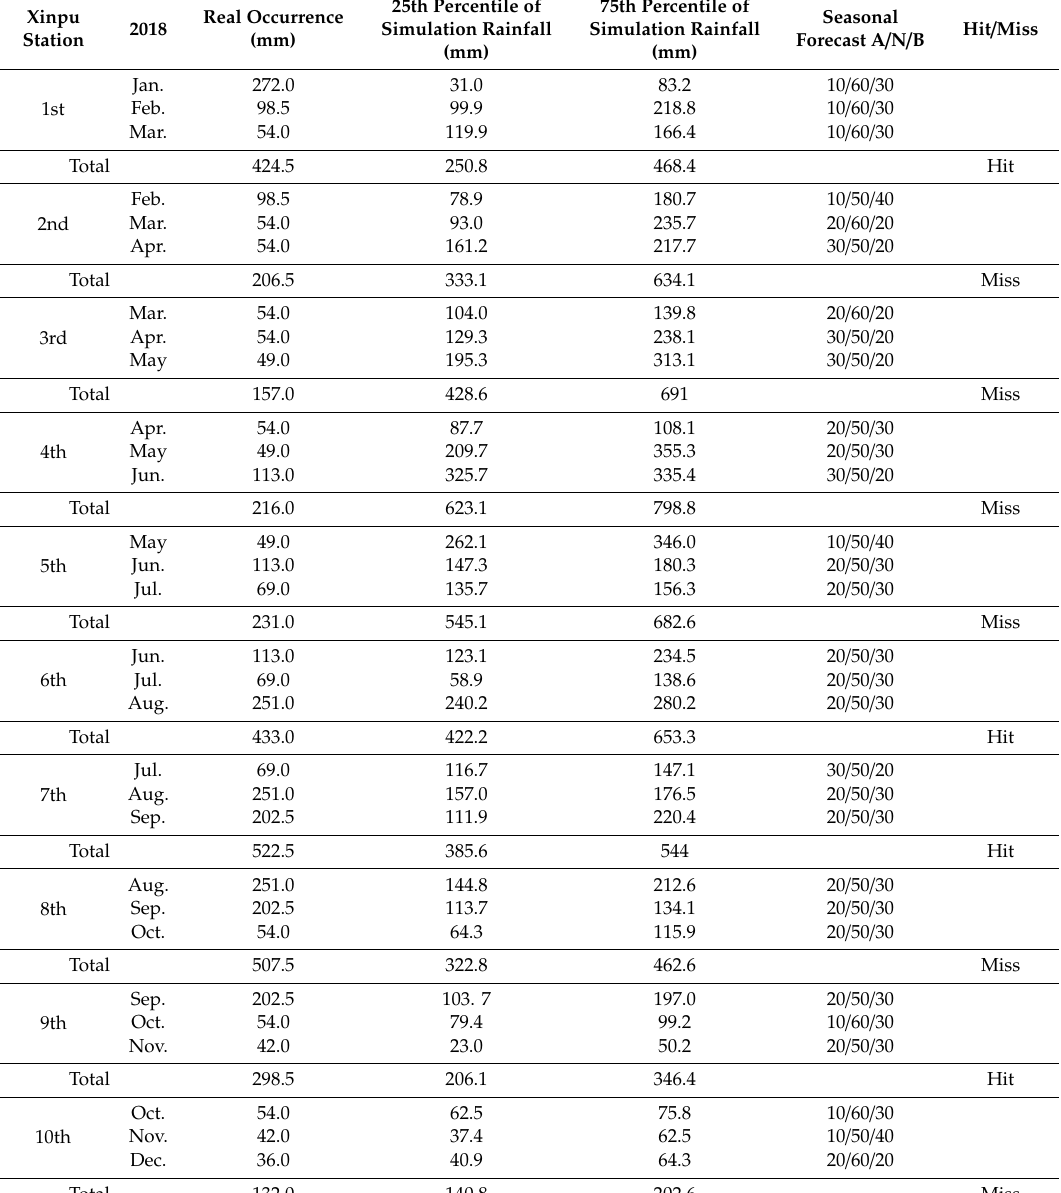
Table 4. Ten sets of seasonal rainfall outlooks and real rainfall occurrences of Xinpu station in 2018. Xinpu